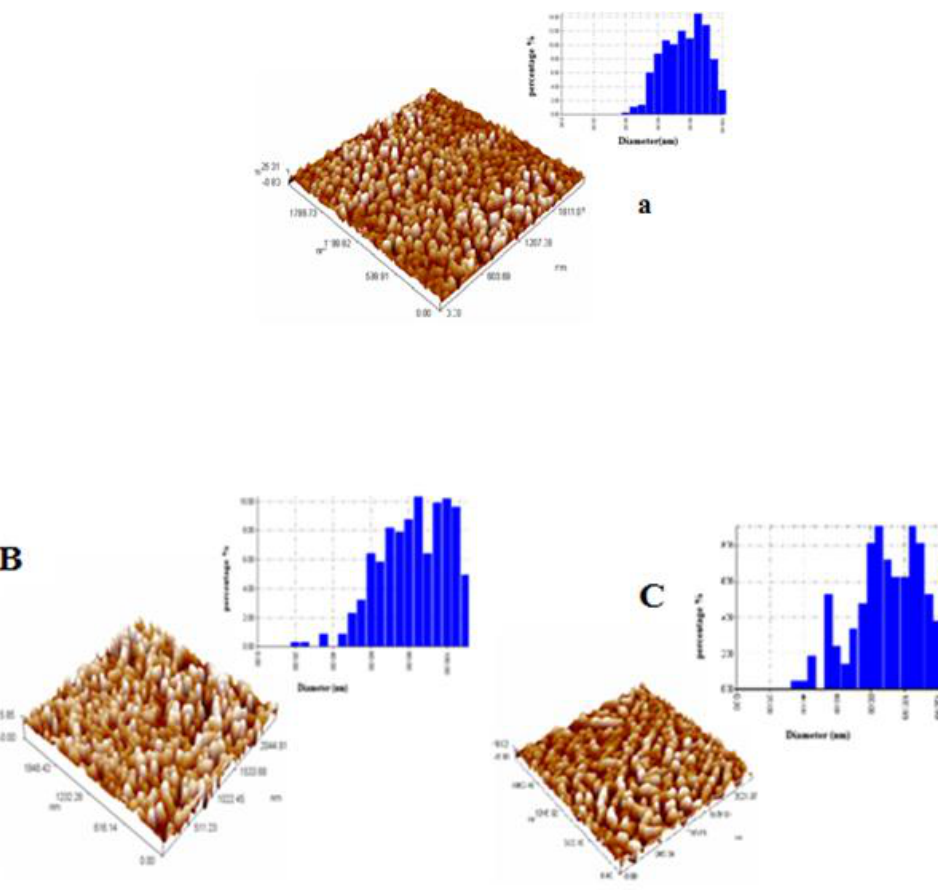
Si Al O ) where (a) x= 0, (b) x=0.1 and (c) x=0.4 1-x x 2 4